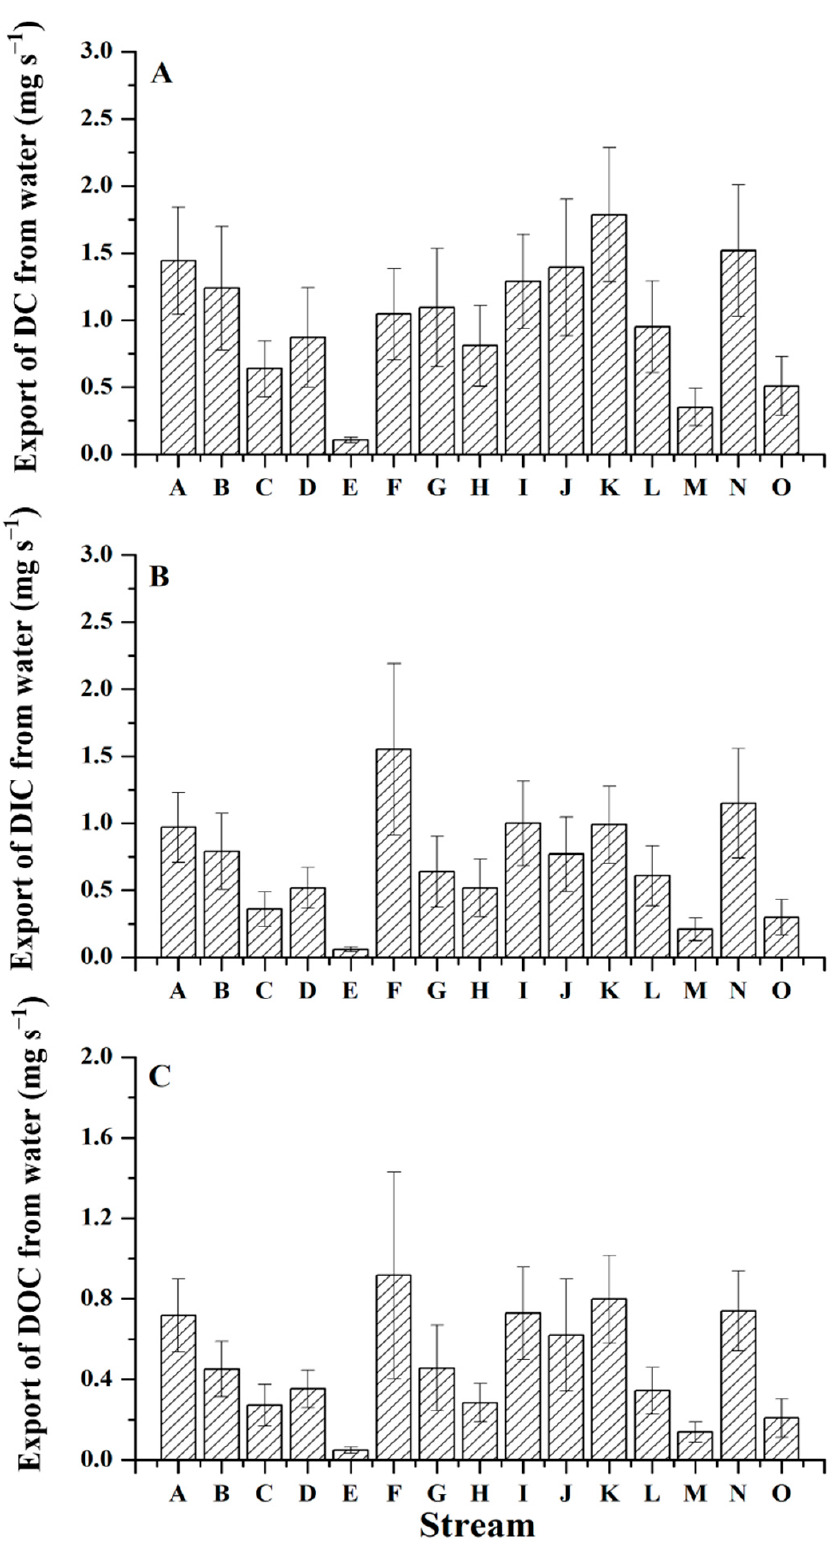
Figure 4. Dynamics of dissolved carbon (DC) export from the subalpine forest streams in the upper reaches of the Yangtze River. Total dissolved carbon stock (DC, ( A )); dissolved inorganic carbon stock (DIC, ( B )); dissolved organic carbon stock (DOC, ( C )). Each bar is the average of 13 sampling times for each forest stream. A–O are the sampled streams in the study.